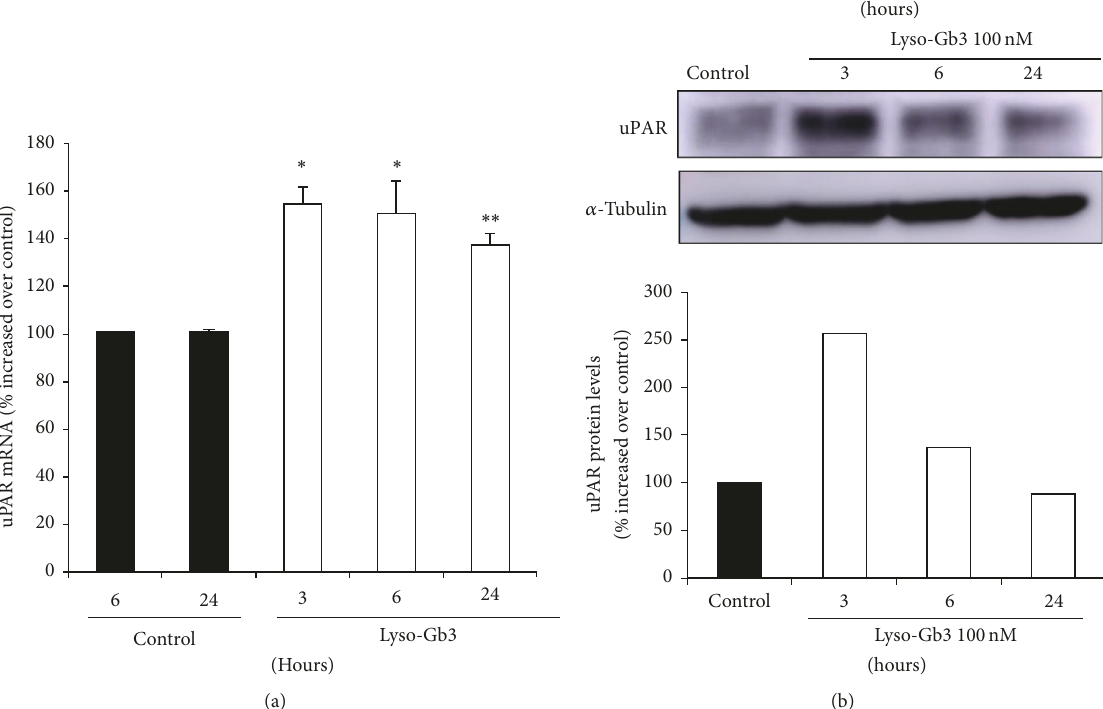
Figure 2: Lyso-Gb3 upregulates uPAR expression in podocytes. Cultured human podocytes were stimulated with 100nM lyso-Gb3. (a) Time course of uPAR mRNA induction. ∗ 𝑝 < 0.002 versus control; ∗∗ 𝑝 < 0.01 versus control. Expression of mRNA was assessed by real-time RT-PCR. Mean ± SEM of four independent experiments. (b) Protein levels of uPAR assessed by Western blot. Representative